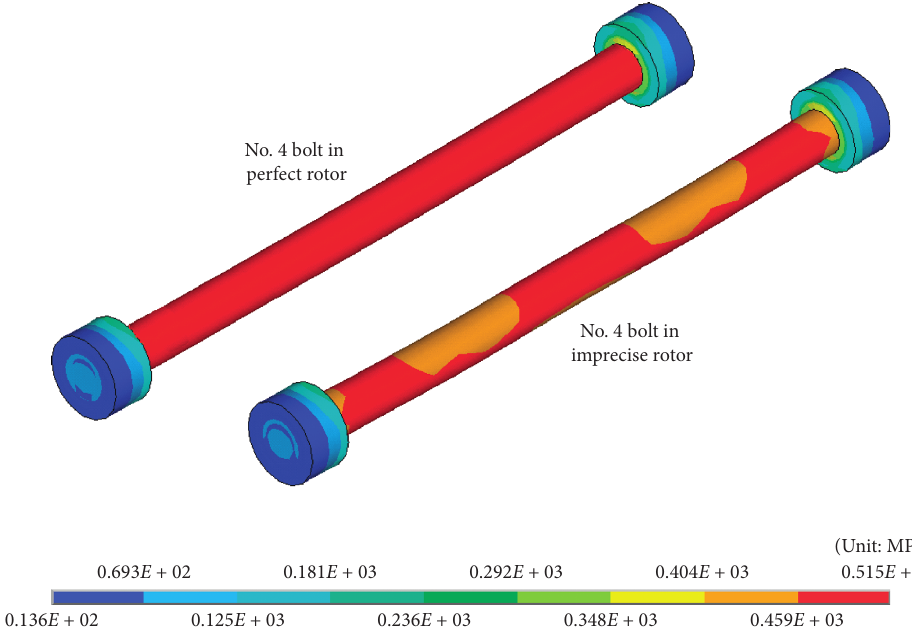
Figure 4: Stress distribution of No.4 bolt in both perfect and imprecise bolt-disc